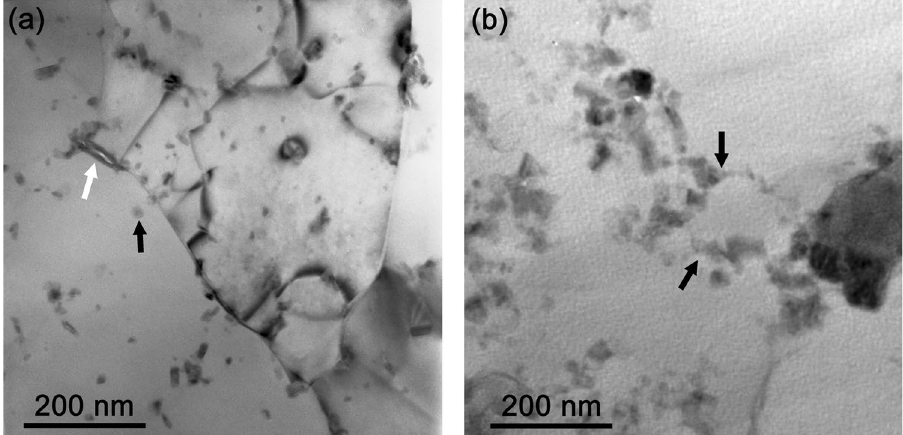
Figure 5. TEM bright field images of transversal-sections of the as-deformed Al + Al 2 O 3 sheaths ( a ) and the heat-treated sheath of wA wire ( b ).